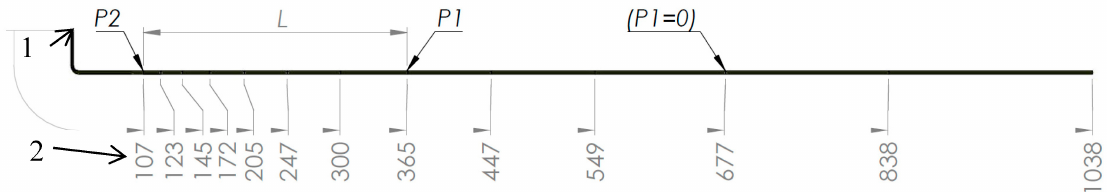
Figure 5. The marked and measured lengths in mm for the calculation of the attenuation coefficients (1—incident light, 2—measured lengths).